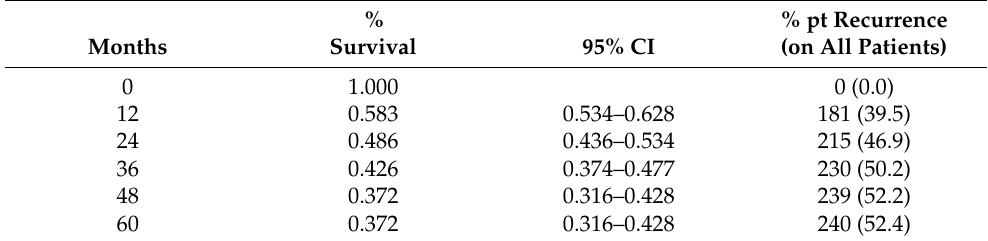
Table 4. Probability of not having a recurrence.